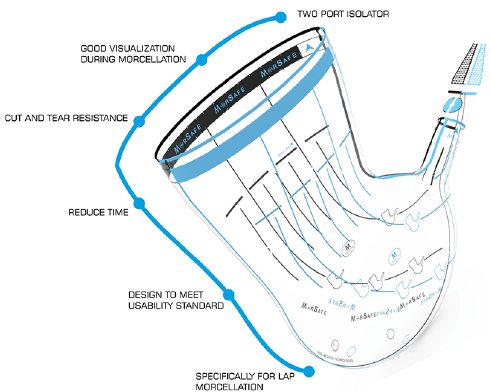
Figure 1. Schematic representation of the in-bag morcellation system MorSafe ® (reproduced with permission from Veol Medical Technologies Pvt. Ltd., Navi Mumbai, India).